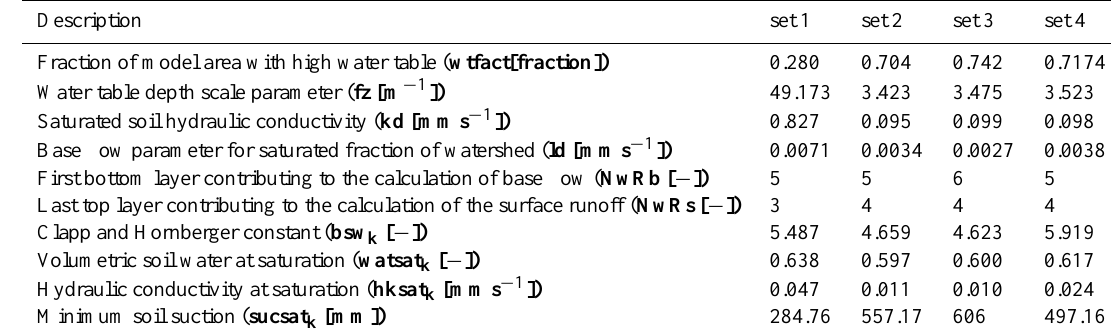
Table 1. Optimal parameter sets: NwRb and NwRs were converted into tuneable parameters (De Lannoy, 2006b), k is the soil layer index. NwRb and NwRs are not considered in the parameter resampling step.